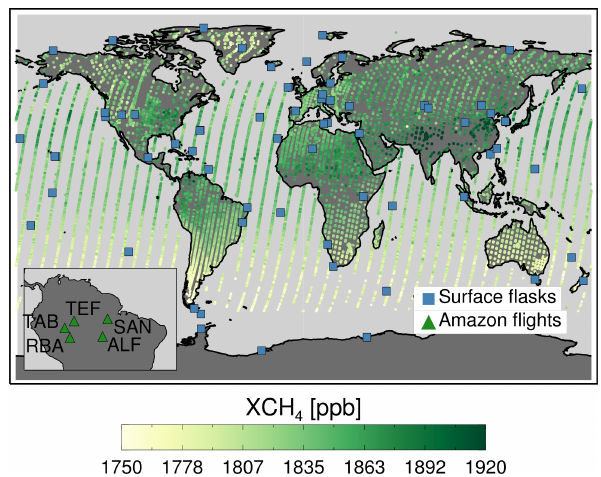
Figure 1. Locations of NOAA surface sites from which flask-based measurements of CH 4 are assimilated (blue squares), along with locations and values of GOSAT XCH 4 retrievals for August 2017 (circles). Inset shows locations of flight-based observations of CH 4 within the Amazon basin (green